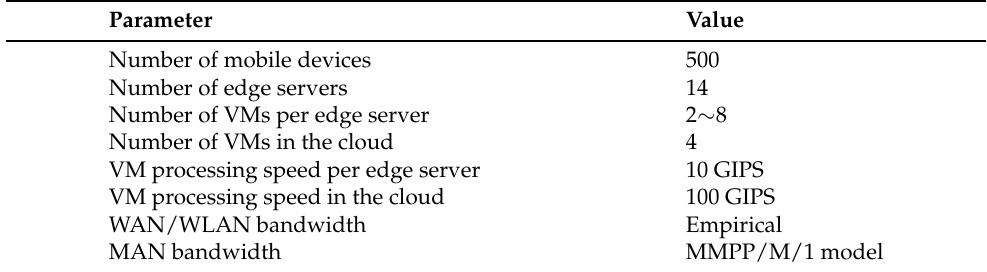
Table 6. Simulation parameters